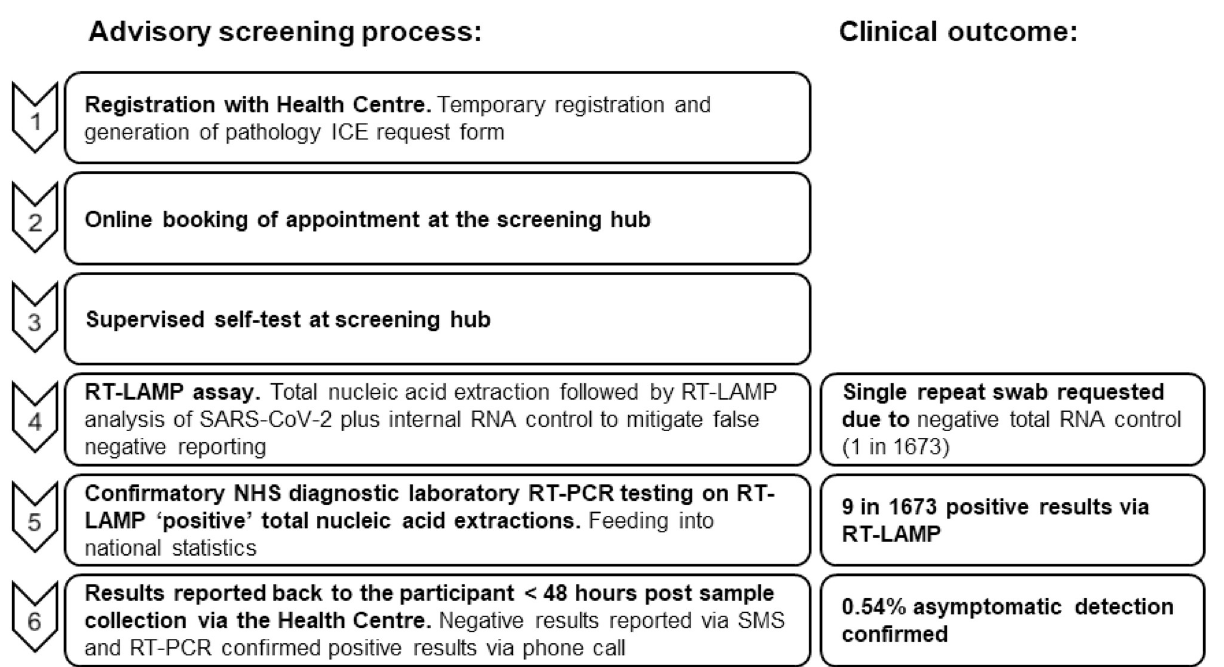
Fig 1. University of Leicester SARS-CoV-2 advisory screening programme. Available to all students and staff without symptoms for a period of twelve weeks (October 2020 –December 2020) to allow rapid isolation and reduce outbreaks.